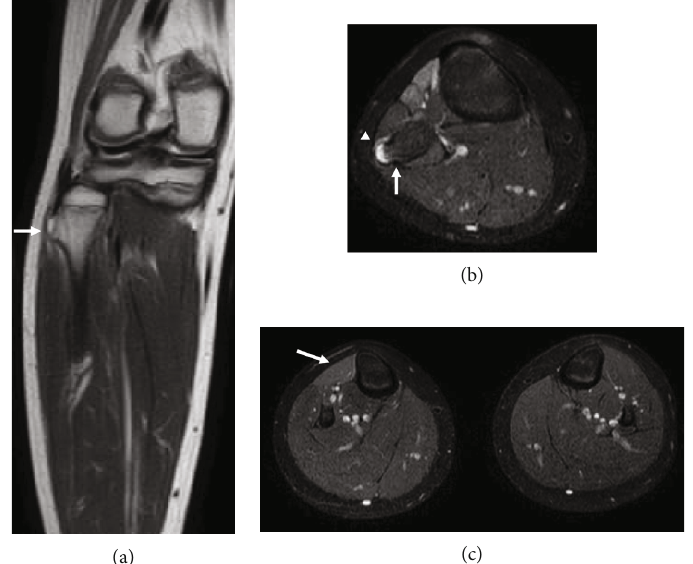
Figure 2: T2-weighted magnetic resonance imaging (MRI) showing (a, b) osteochondroma of the fi bular head compressed peroneal nerve (white arrow: osteochondroma; white triangle: peroneal nerve) and (c) atrophy of the tibias anterior (white arrow: tibias anterior).